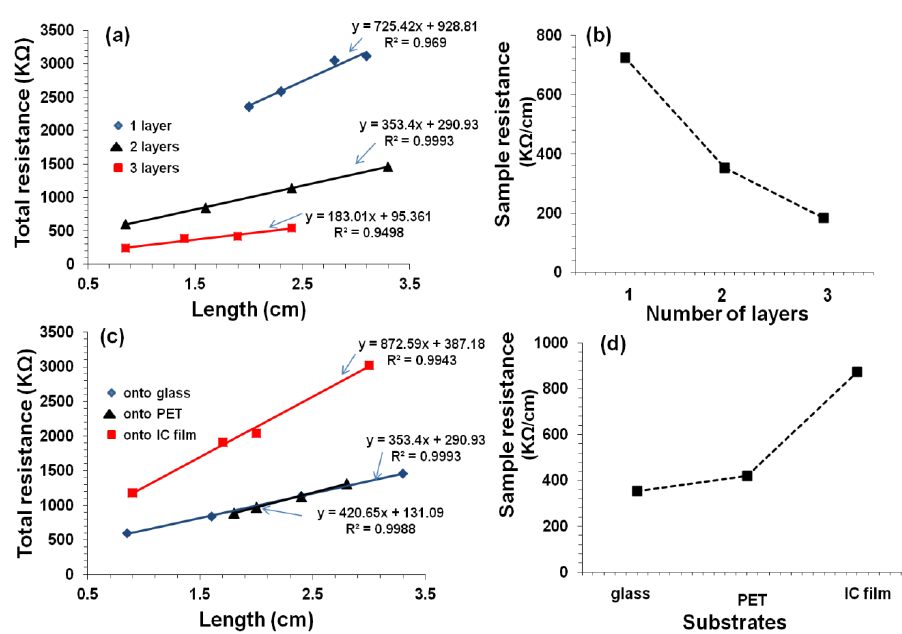
Figure 12. Resistance vs. length for extruded patterns of IC-MWNT ink. ( a ) 1–3 printed layers onto microscope glass substrates; ( b ) sample resistance of 1–3 printed layers on microscope glass substrates, derived from the slope of the lines in ( a ); ( c ) Resistance vs. length for extruded two layers patterns on glass, PET and IC films substrates; ( d ) Sample resistance of the tracks printed onto different substrates, derived from the slope of the lines in ( c ).